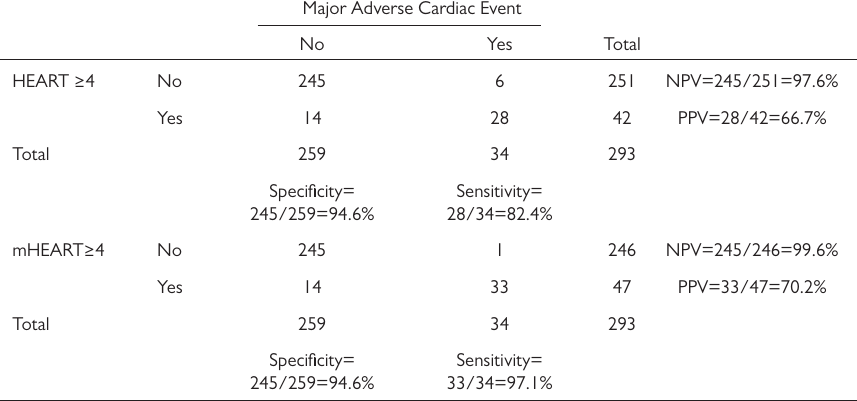
Table 2. Test classification results of HEART and mHEART scores in predicting MACE Major Adverse Cardiac Event